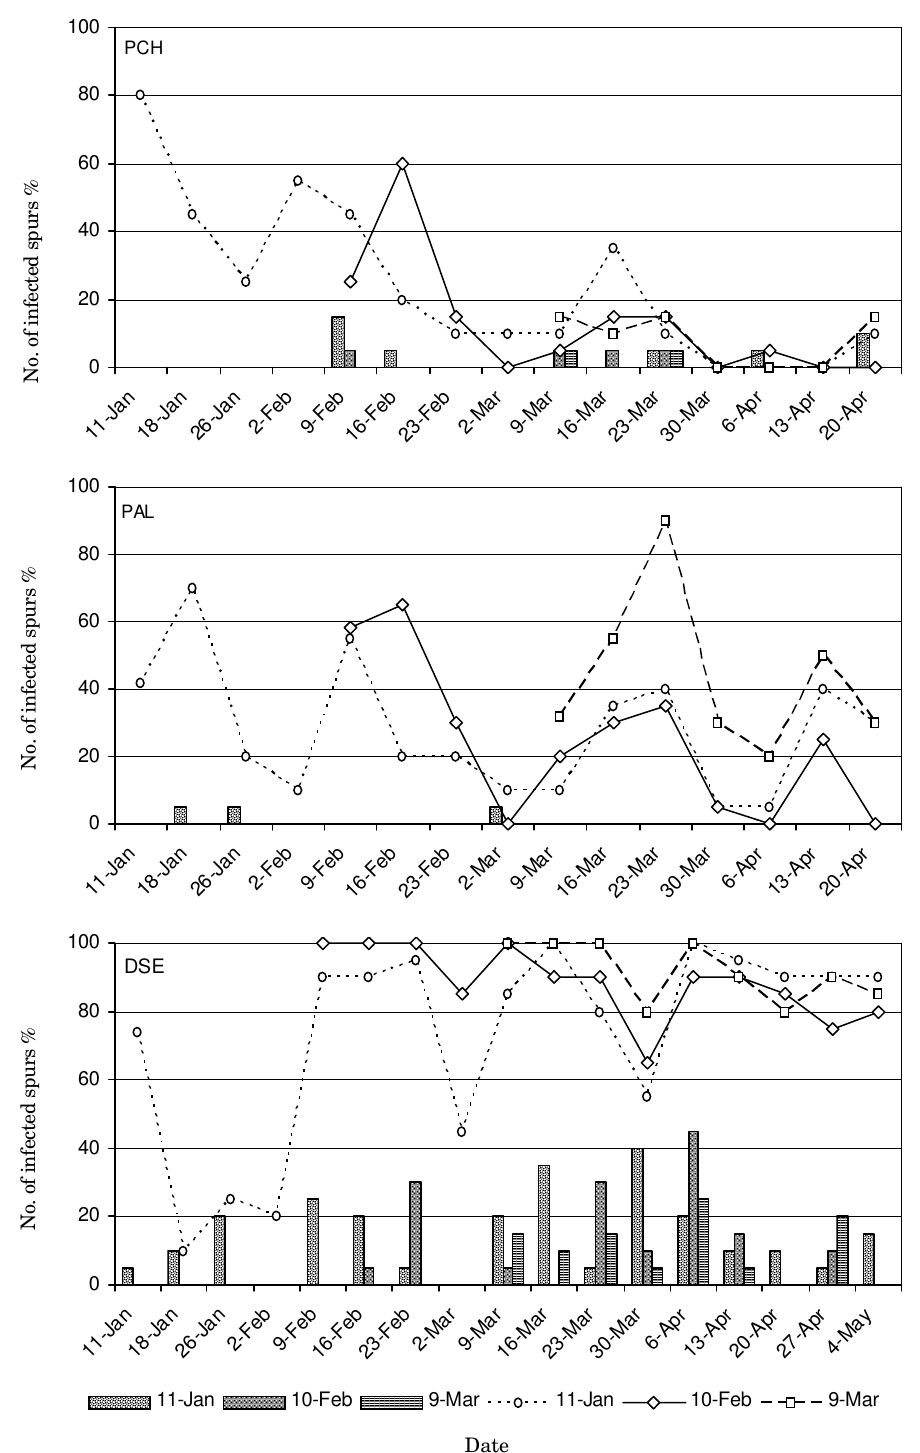
Fig. 2. Weekly infection percentages of spurs pruned in January, February and March and arti fi cially inoculated (dotted lines) or naturally infected (bars) with Phaeomoniella chlamydospora (PCH), Phaeoacremonium aleophilum (PAL) or Diplodia seriata (DSE) in